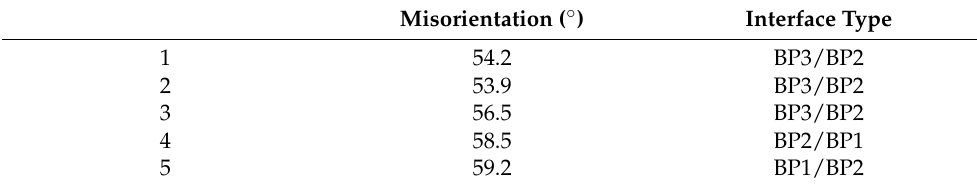
Table 3. The misorientation and type of interface where crack propagation was